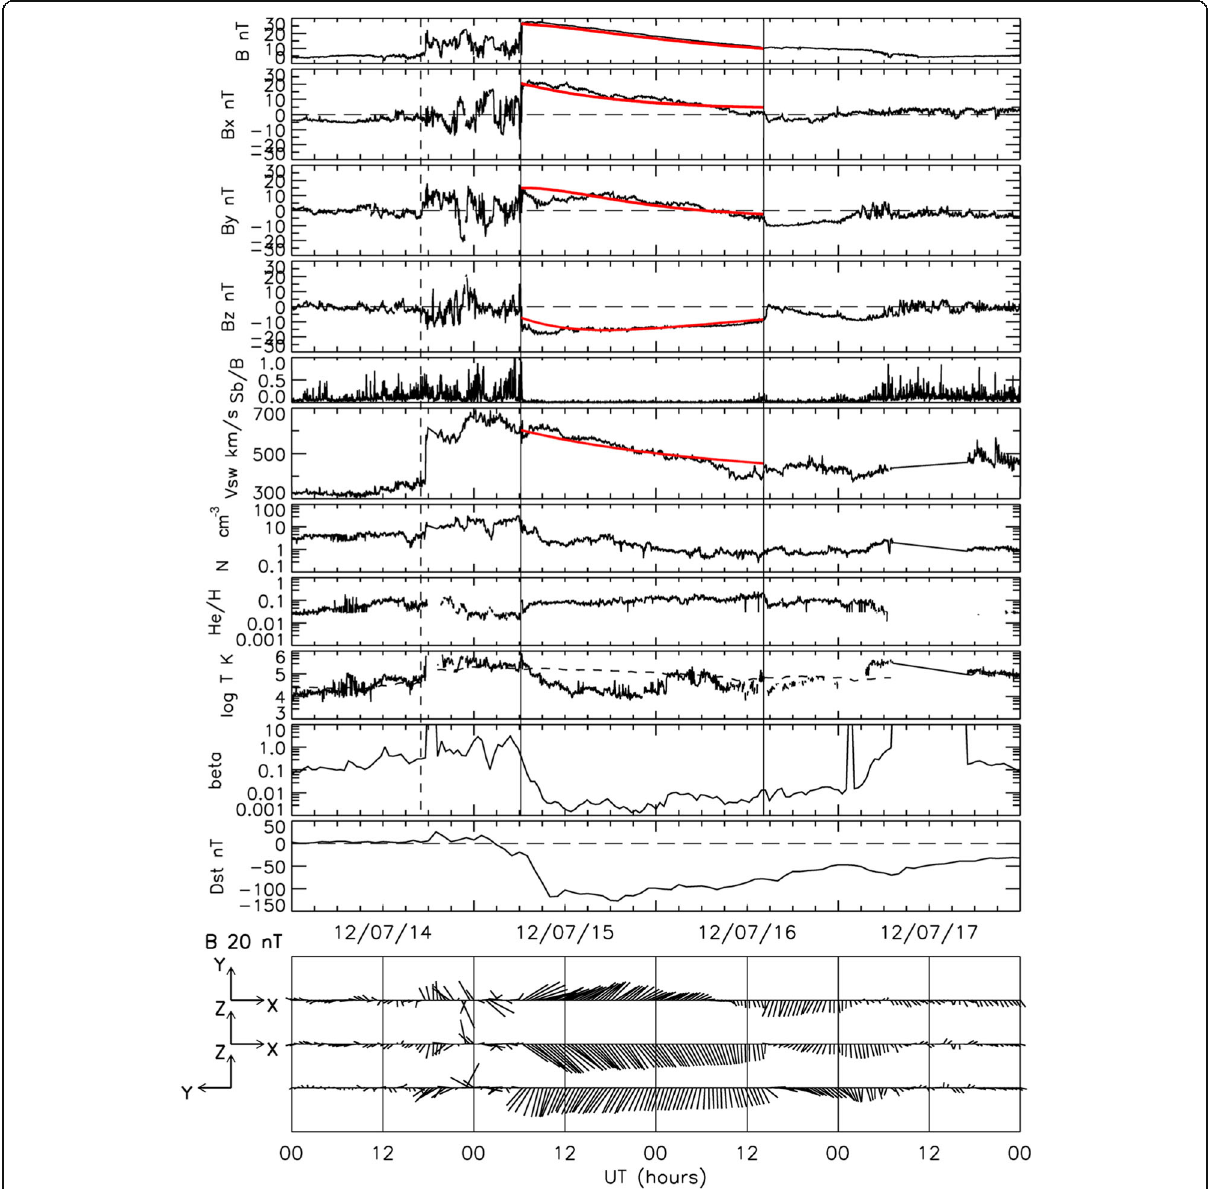
Fig. 18 Solar wind data from Wind and the Dst variation for three days, 8 – 10 October 2012. From top to bottom are plotted the IMF intensity ( B ), X -, Y -, Z -components in GSE coordinates ( B x , B y , B z ), the degree of field fluctuations defined by the standard deviation divided by averaged intensity obtained from higher time resolution data (Sb/ B ), solar wind speed ( V sw ), proton number density ( N ), number density ratio of He++ to H+ (He/H), proton temperature, plasma β , and the Dst index. The vertical dashed line indicates the shock arrival time (on 8 October at 04:12 UT) and the two vertical lines indicate the flux rope (from 8 October at 17:20 UT to 9 October at 18:30 UT). The red curves show the model values obtained from the fitting with a toroidal flux rope model. Adapted from Marubashi et al.